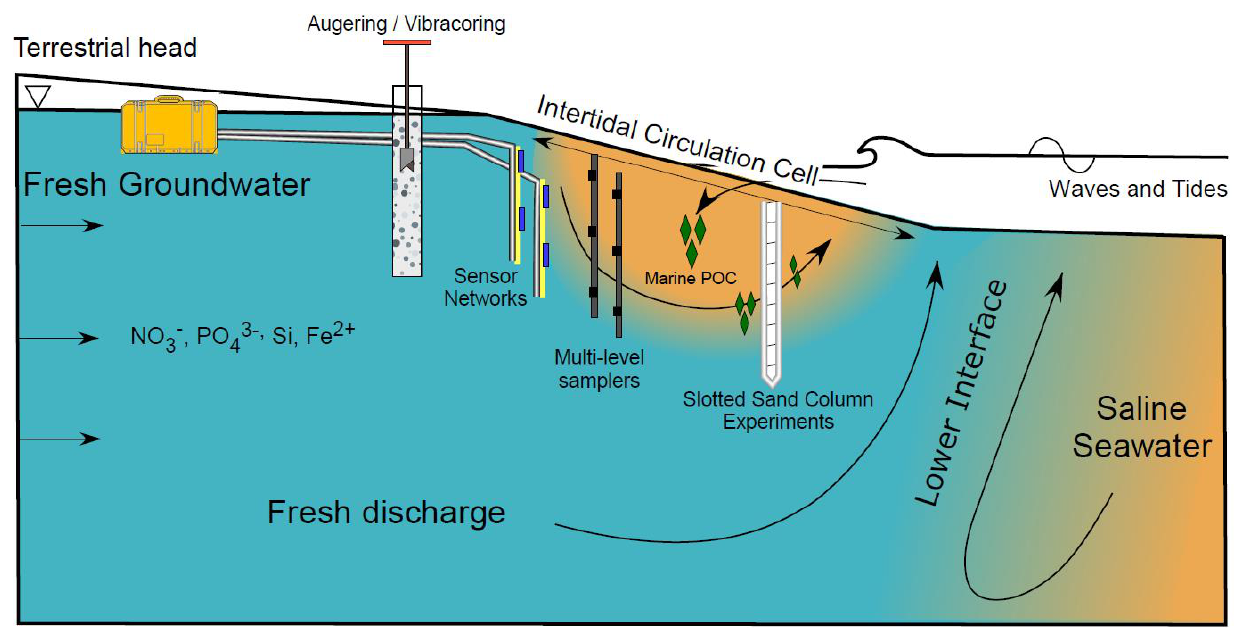
Figure 1. Schematic of a beach aquifer with an intertidal circulation cell. Several instrumentation and methodological examples are illustrated, including augering and vibracoring, sensor networks, multi-level porewater samplers, and slotted sand column experiments.